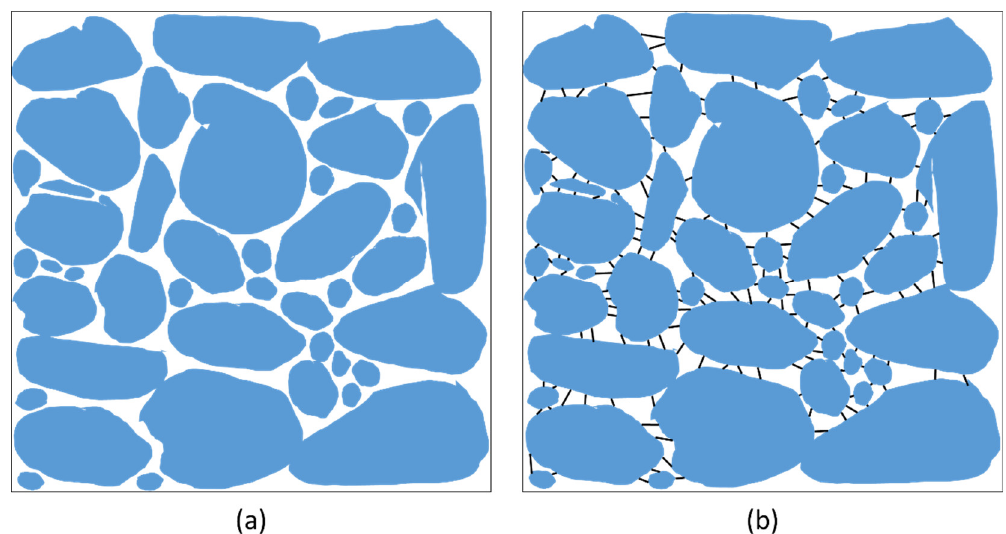
Figure 2. The illustration of ( a ) sintered ceramic matrix composite (CMC) and ( b ) sintered carbon nanotubes reinforced ceramic matrix composite (CNTs-CMC). As compared to bare CMC, the CNTs-CMC grains are tailored through CNTs bridging (the black lines in ( b )). Homogenous CNT dispersion and bridging (interfacial adhesion) restricted the crack propagation and improved the fracture toughness of CNTs-CMC.